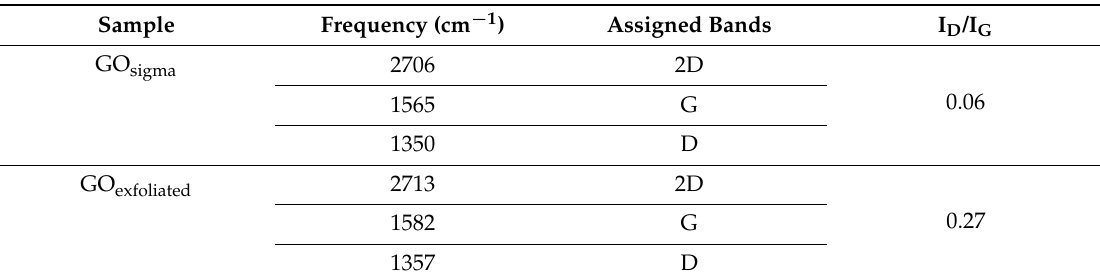
Table 1. Raman parameters for GO sigma and GO exfoliated .